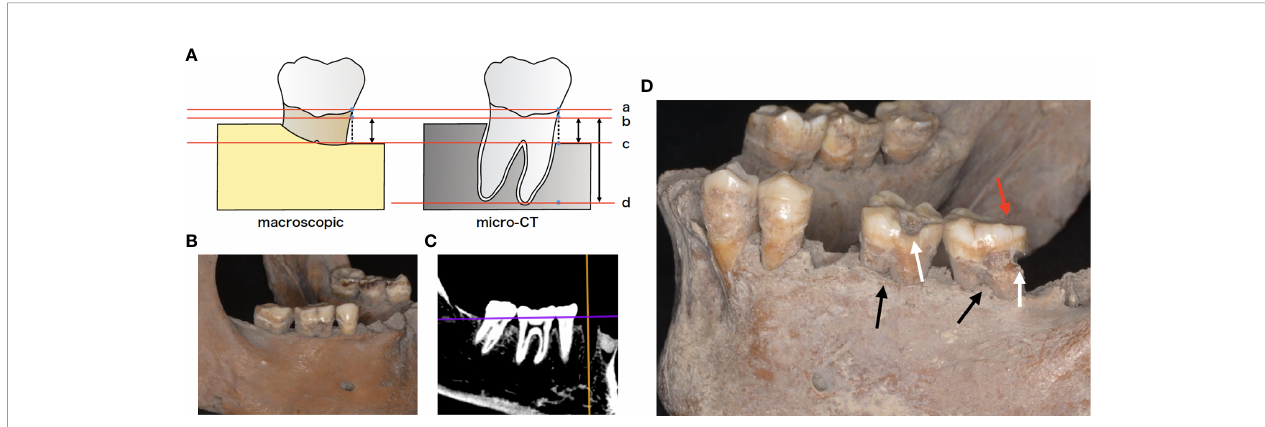
FIGURE 1 | (A) Schematic representation of the morphologic examination. Bone resorption was de fi ned as the distance from virtual alveolar crest, which was obtained by subtracting 1 mm from the cemento-enamel junction to the bottom of the nearest bone defect (b, c). Bone resorption was measured using both periodontal probe and micro-computed tomography (micro-CT). Root length was de fi ned as the distance from virtual alveolar crest to the apical end of the root (a – d). Bone resorption ratio was calculated as (b-c)/(b-d). a cement-enamel junction (CEJ), b virtual alveolar crest, c bottom of bone defect (bone level), d: apical end of the root. (B) Mandibular skeleton (sample F24). (C) micro-CT image of the same bone. (D) Tooth morphologic characteristics. White arrows indicate cavities, while black arrows indicate furcation involvement. Red arrows indicate occlusal